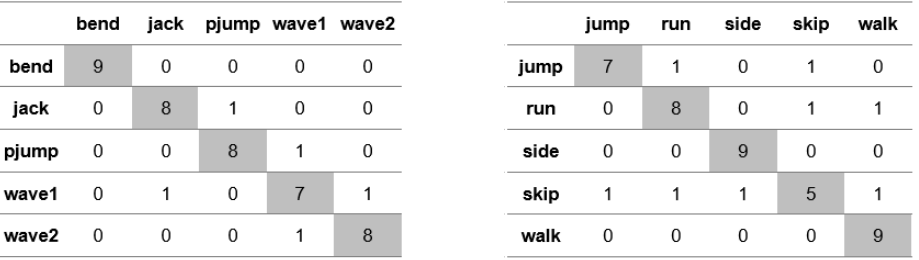
Figure 6. Confusion matrices for the best experiment using the ‘upper-occlusion’ database. ( Left ta- ble ): ‘actions performed in place’ subgroup, Elongation, C1 correlation, 51 DFT coefficients, accuracy 88.89%. ( Right table ): ‘actions with changing location of a silhouette’ subgroup, Rectangularity, C1 correlation, 46 DFT coefficients, accuracy 84.44%.